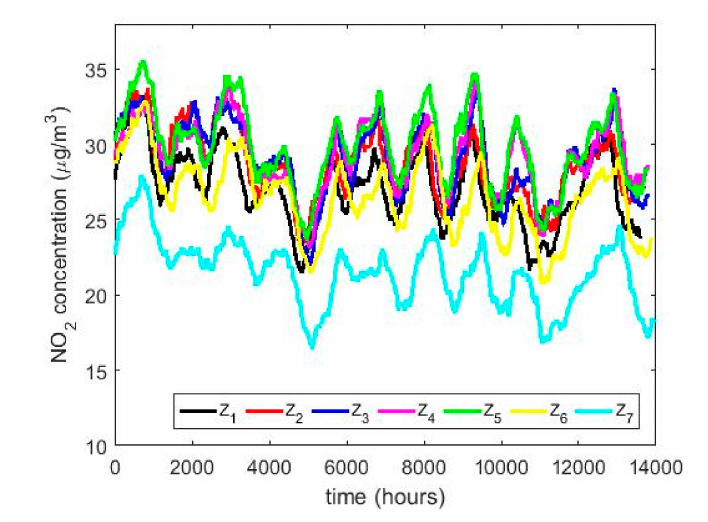
Figure 9. Moving average of the NO 2 concentrations: Z 1 (Monday), Z 2 ( Tuesday), Z 3 (Wednesday), Z 4 (Thursday), Z 5 (Friday), Z 6 (Saturday), and Z 7 (Sunday).